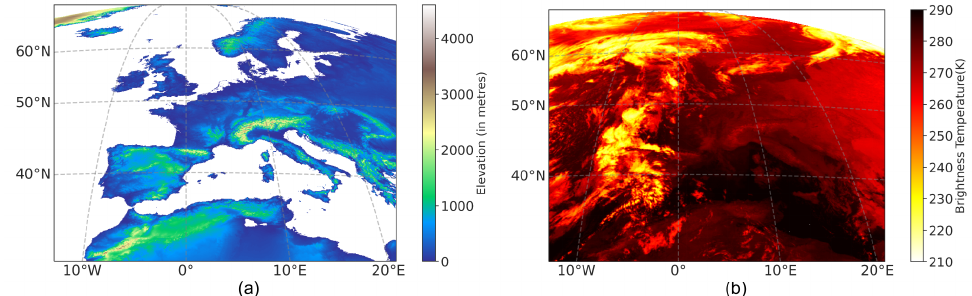
Figure 2. Region of interest for the inter-calibration of Meteosat datasets ( a ) DEM (Source: WorldClim DEM [28]), and ( b ) an exemplary MFG scene IR channel—30 October 2005,